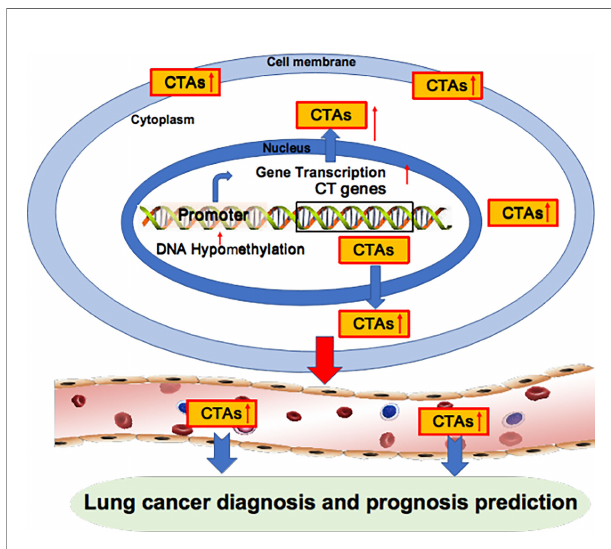
FIGURE 2 | Oncogenic CTAs as targets for lung cancer diagnosis and prognosis prediction. Oncogenic CTAs are overexpressed due to hypomethylation of the gene promoter, resulting in robust gene transcription. CTAs are secreted from cancer cells and enter blood circulation. Thus, CTAs can be detected in the blood and used as biomarkers for lung cancer diagnosis and prognosis